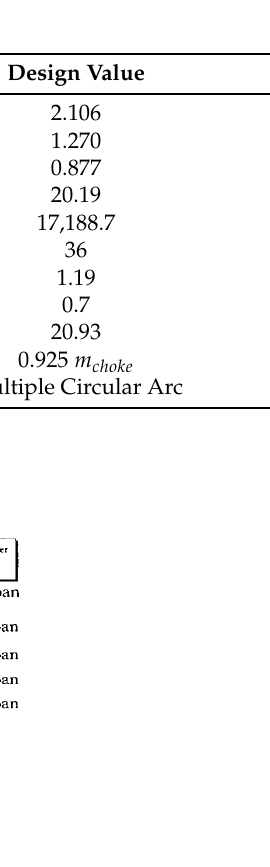
Figure 5. Measurement stations